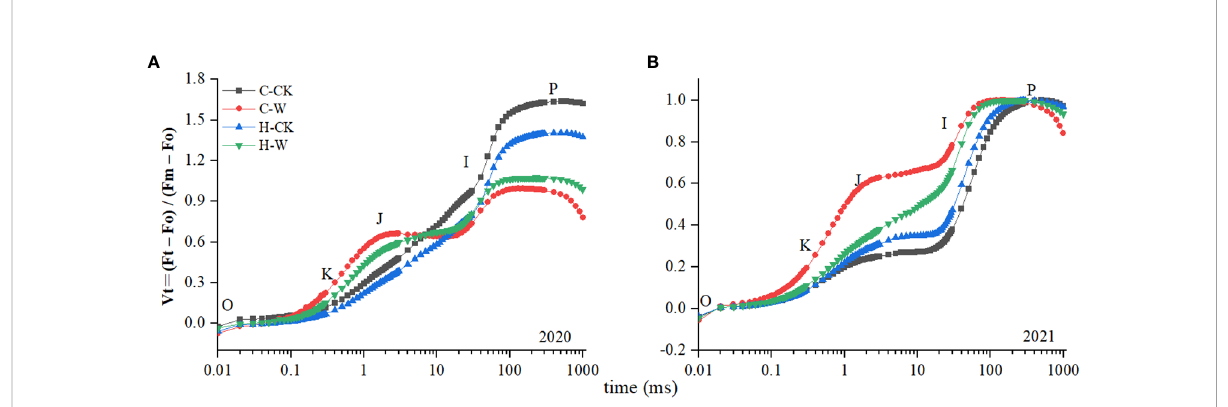
FIGURE 5 Changes in PS II donor/acceptor sides. (A, B) Vt curves in 2020 and